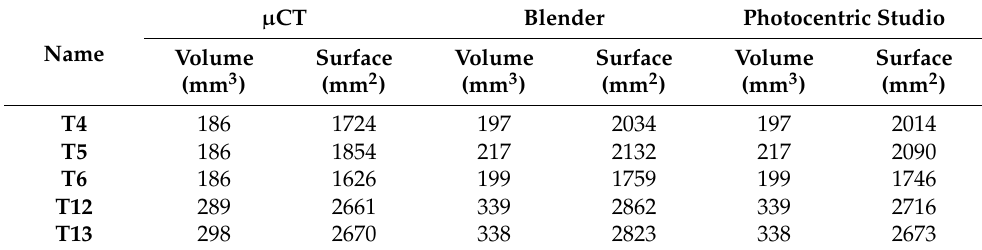
Table 4. The comparison of tablets attributes measured and calculated with different